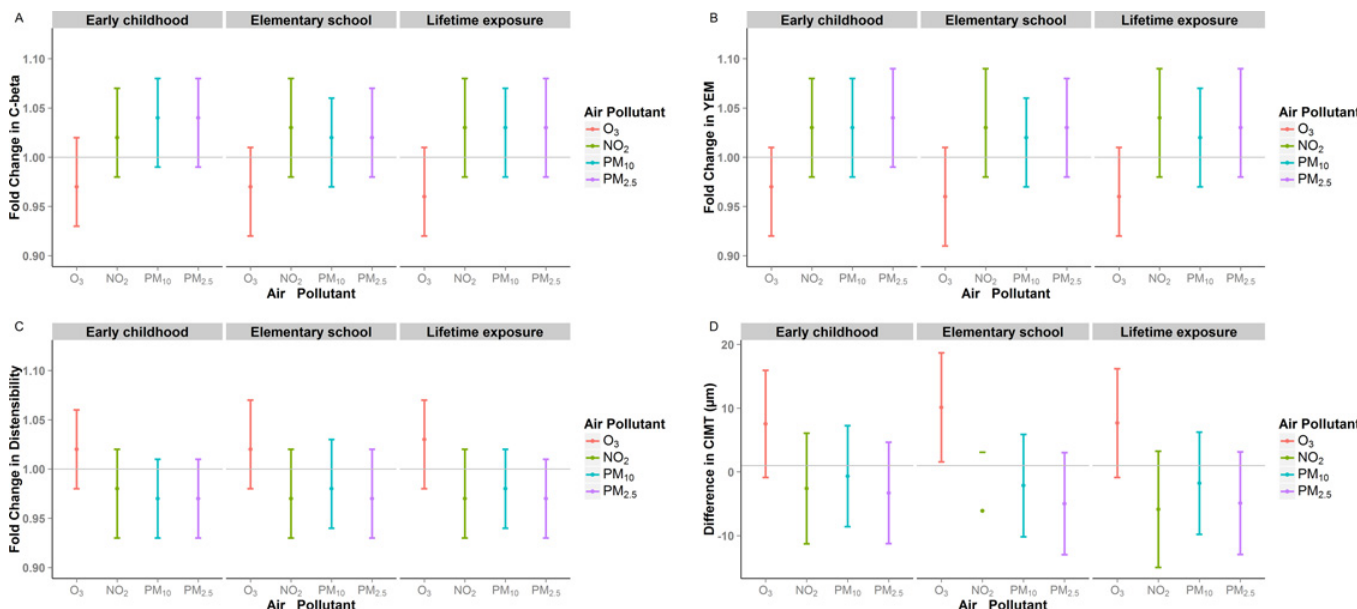
Fig 2. The association between postnatal air pollutant exposures and A) C-beta, B) YEM, C) Distensibility, and D) CIMT, by early childhood, elementary school and postnatal exposure.